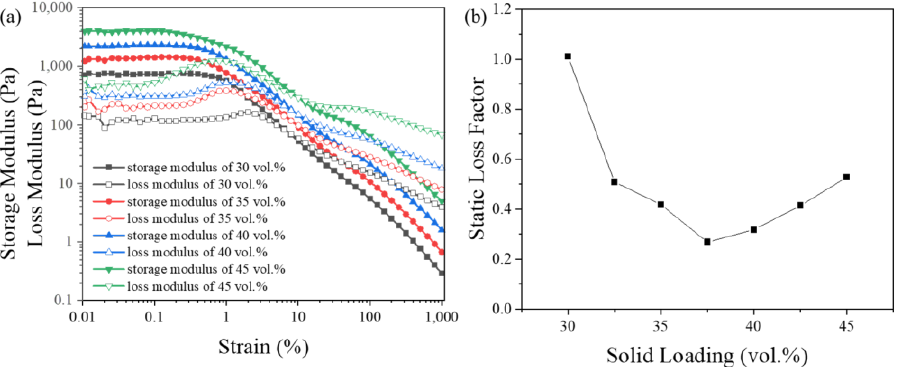
Figure 6. Effects of solid loading of ZF2 slurries on ( a ) modulus under various strain and ( b ) static loss factor.